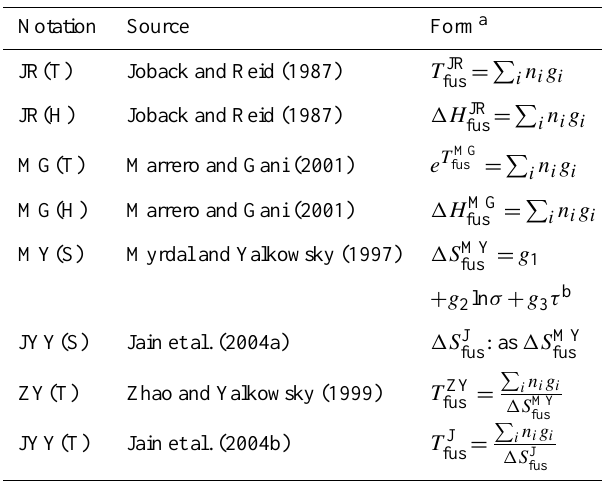
method gives a very large error on the fusion